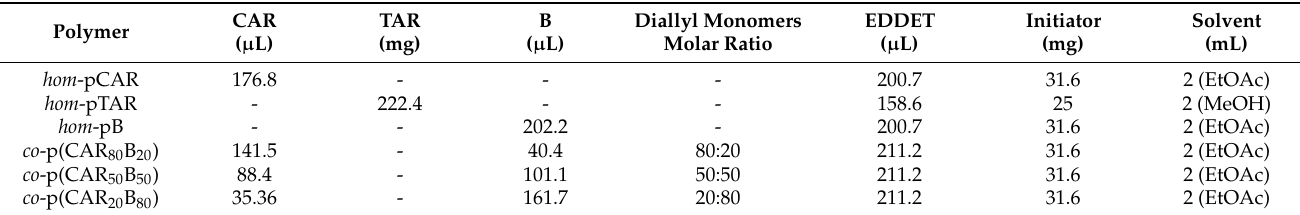
Table 2. GPC and TGA data for synthesized homopolymers and